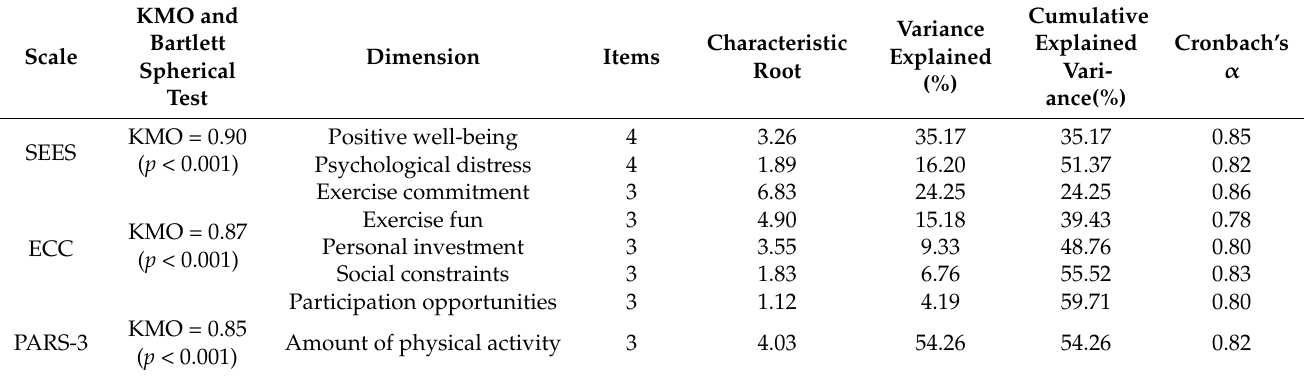
Table 1. Factor extraction and reliability analysis of the three measurement